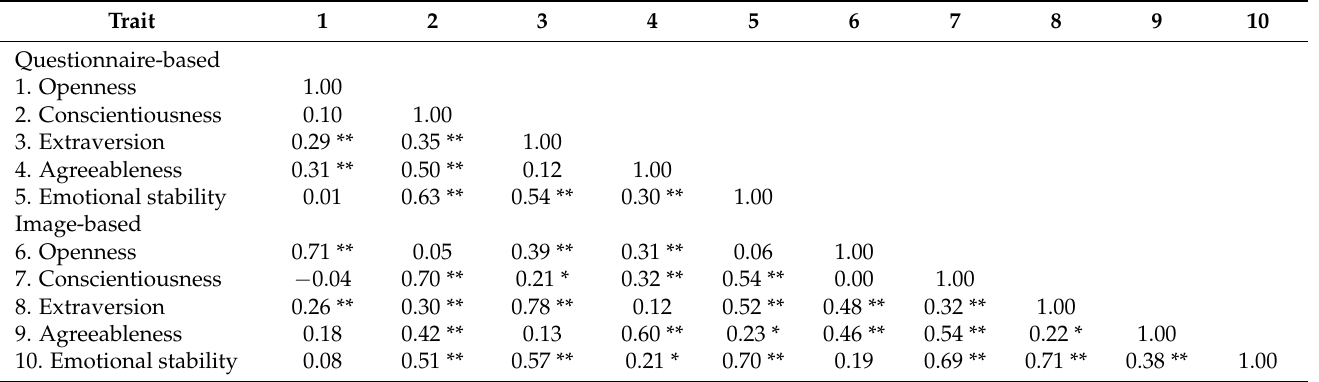
Table 4. A multitrait-multimethod matrix investigating the convergent and discriminant validity of the image- and questionnaire-based measures (Test set of sample 2; n =